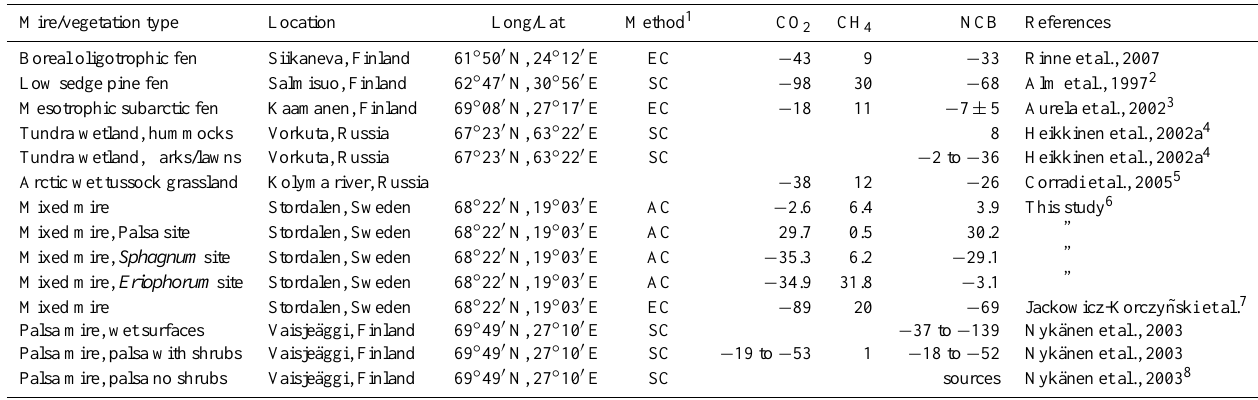
Table 6. Compilation of annual net carbon balances (NCB in gCm − 2 ) for northern mires where the exchange of both CO 2 , CH 4 and sometimes NMVOCs and DOC/DIC leaching are represented in the C balance estimation. All units in gCm − 2 . If the CO 2 and CH 4 components are not specified in the table, this information could not be revealed from the specific